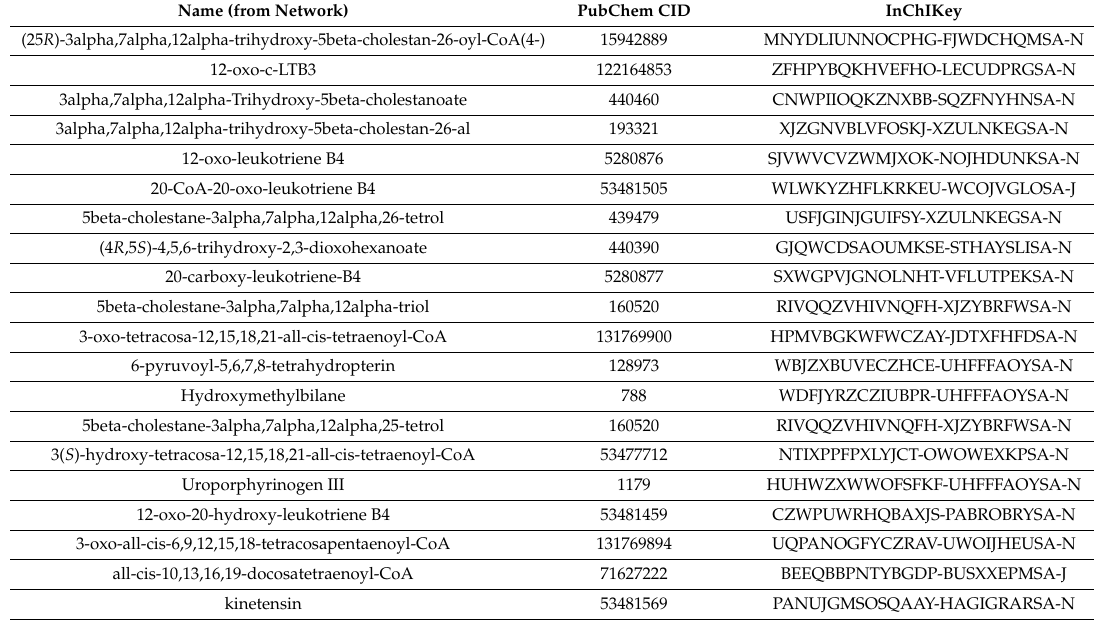
Table 1. Top 20 metabolites with the highest overall betweenness centrality from the poorly mapped area of human network. PubChem CIDs were obtained using the Chemical Translation Service (http://cts.fiehnlab.ucdavis.edu/) with the name as presented in the first column. Name (from